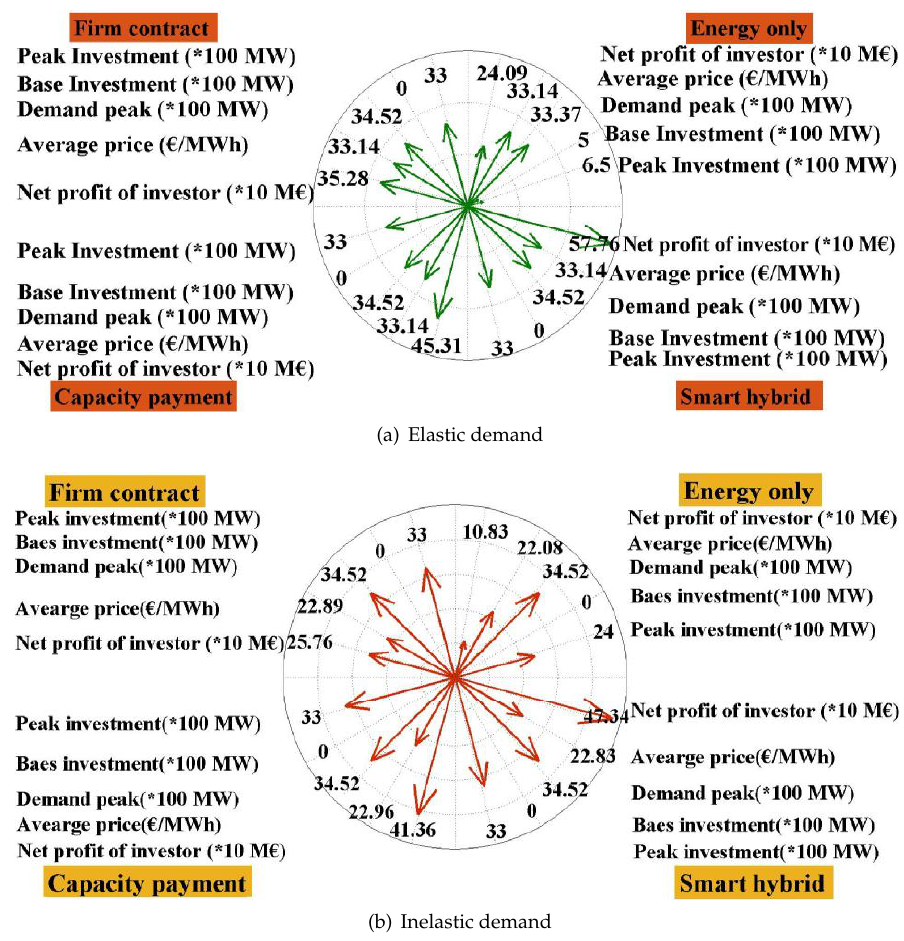
Figure 10. Results of generation expansion planning for MERC with ( a ) inelastic ( b ) elastic